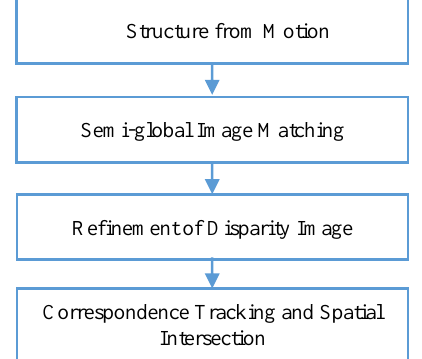
Figure 1. The workflow of the proposed UAV-image-based dense point cloud generation